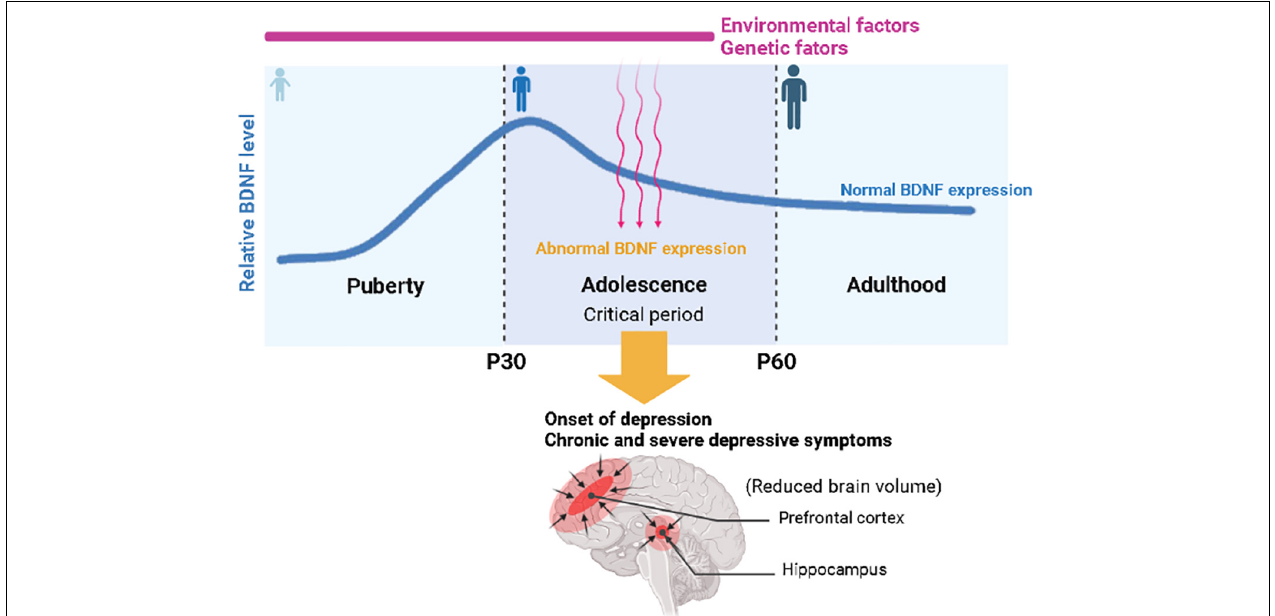
FIGURE 1 | Schematic illustration of the association between environmental and genetic risk factors related to brain-derived neurotrophic factor (BDNF) expression for the onset of depression in adolescence. Relative BDNF levels peak in early adolescence and gradually decrease with age. Abnormal BDNF expression due to genetic and environmental factors during adolescence may trigger the onset of depression and lead to chronic and severe depressive symptoms, with a risk of a smaller prefrontal cortex and hippocampus, leading to the susceptibility to mood